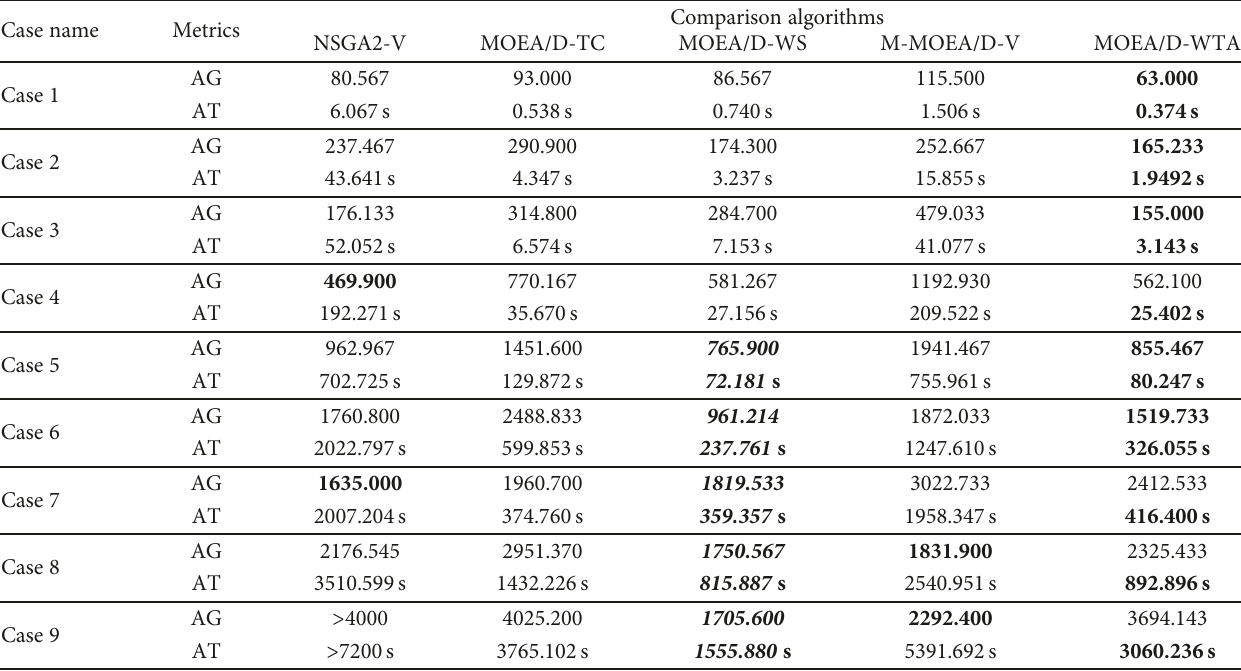
Table 4: Results of AG and AT for the comparison